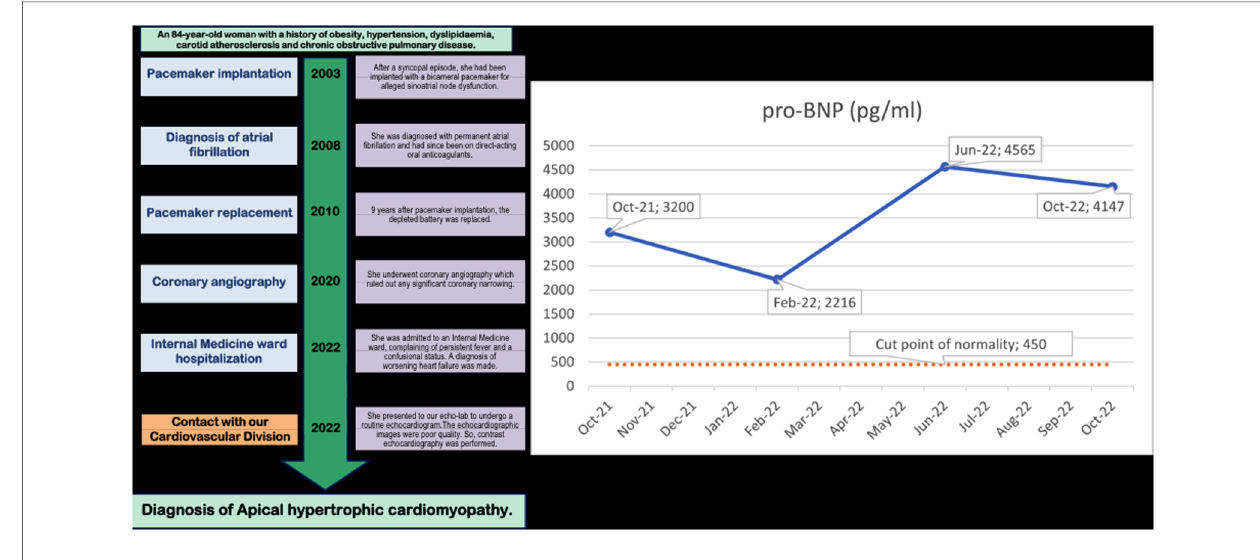
FIGURE 1 Timeline of clinical events in the 20 years before the diagnosis (on the left) and Pro-BNP values in the previous year (on the right). The Pro-BNP values are mildly but consistently abnormally high in each of the 4